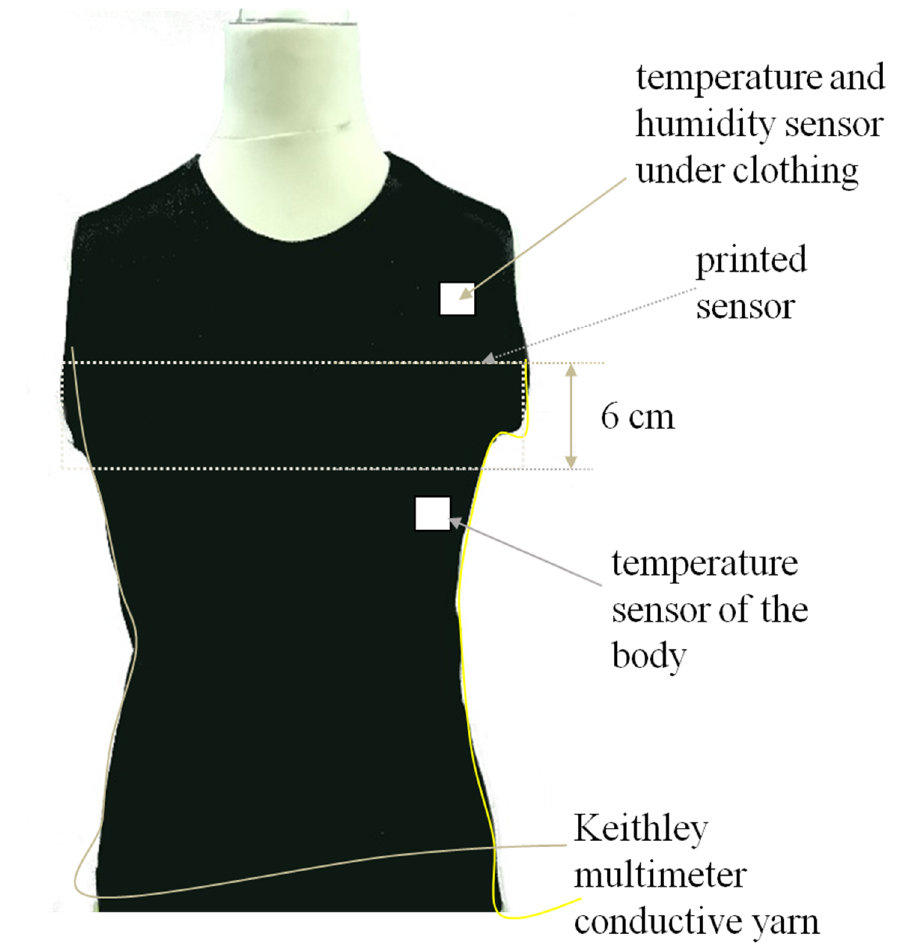
Figure 3. T-shirt with imprinted sensor.